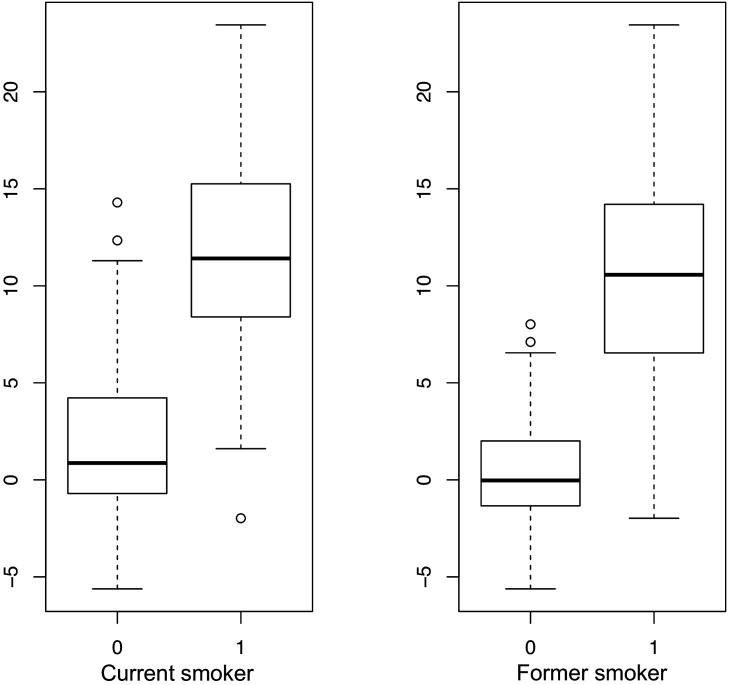
Current and former smokers are characterized by a significantly higher smoking score derived from DNA methylation data than non-smokers.Shown is the DNA methylation smoking score (y-axis) from individuals in the IoPPN cohort for whom self-reported smoking data was available regarding current (left panel) and former (right panel) smoking behavior. 0 = no, 1 = yes.